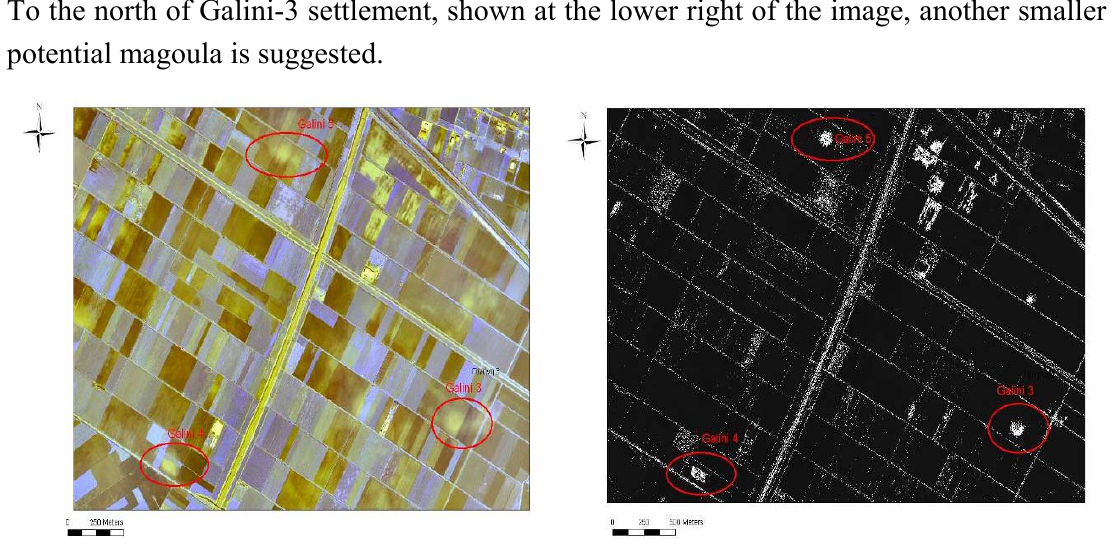
Figure 12. Appearance of the Anagennisi 2 Settlement to band 1 of IKONOS